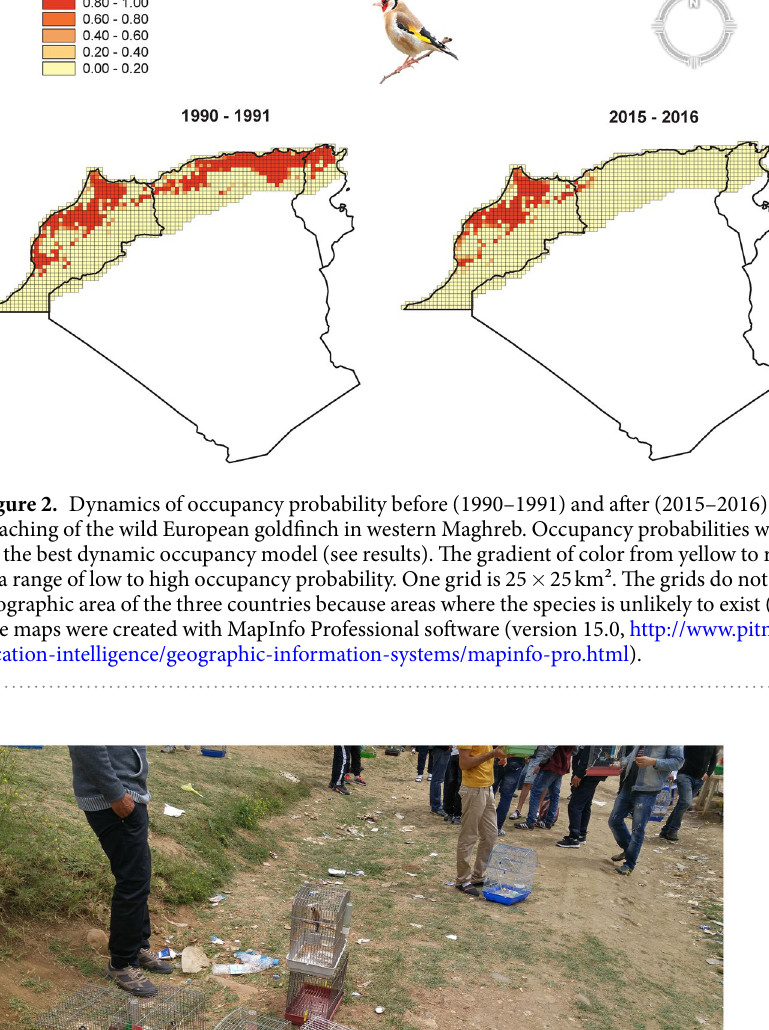
decline as much as Algerian and Tunisian populations. First, there might be differences in poaching pressure between the three countries of western Maghreb so that Moroccan natural populations of goldfinch were less exploited than Algerian and Tunisian populations during the 1990s and early 2000s. Second, the higher availabil- ity of forests (an important habitat for the species) in Morocco 32 could have conferred a larger carrying capacity for the species and more resilience to population extinction 33 . Third, the connection with the European popula- tions of goldfinch may also have contributed to the persistence of Moroccan populations. In fact, in terms of dis- tance, Moroccan populations are closer to European populations with a minimum distance between the Spanish and Moroccan coast of 14 km at the Strait of Gibraltar. Thus, it is possible that regular colonization of Moroccan habitats by Spanish populations compensates, to some extent, the effects of intensive poaching 34 .